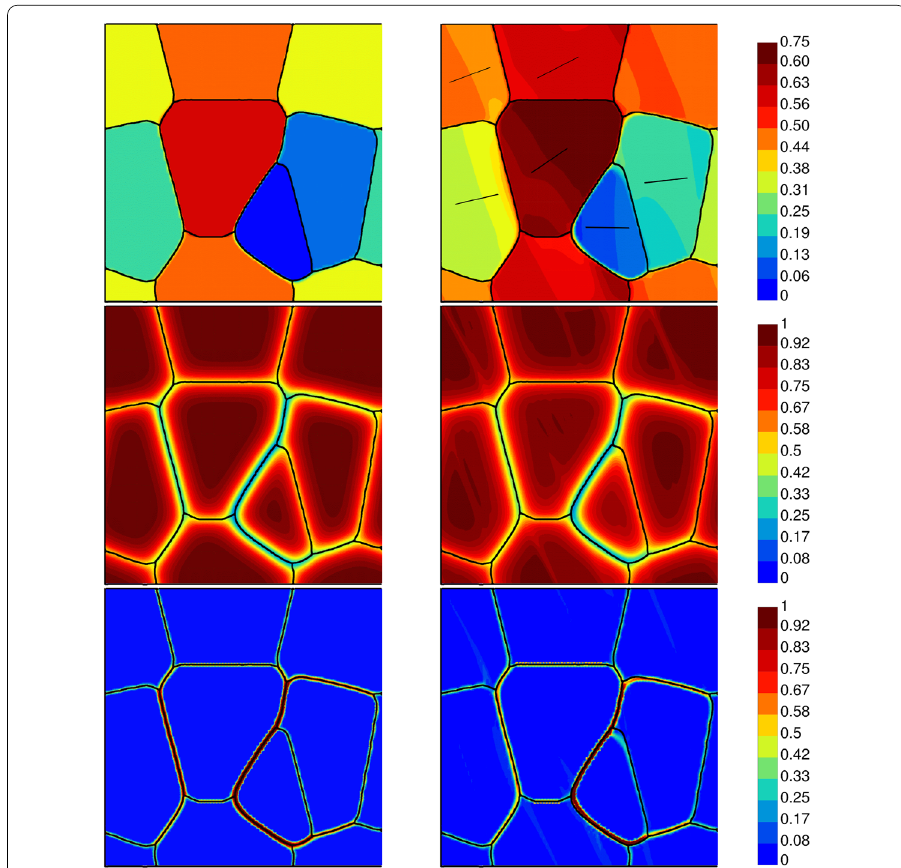
Fig. 4 The six grain microstructure before and after applied shear deformation. The initial values are shown to the left for θ (top), φ (middle) and norm of the curvature |∇ θ | (bottom). Top right shows the orientation distribution after shear deformation, middle right shows the corresponding phase-field φ and bottom right shows the norm of the curvature. The true maximum value of the curvature norm is around |∇ θ | = 1 . 9 µ m − 1 but it has been capped off at 1 µ m − 1 for a better visualization. In the simulation, only one slip system α = 1 was active, resulting in the formation of kink bands. The localization is less pronounced than in the case where only slip system α = 2 was active. The slip direction of each grain is indicated with black lines in the top right